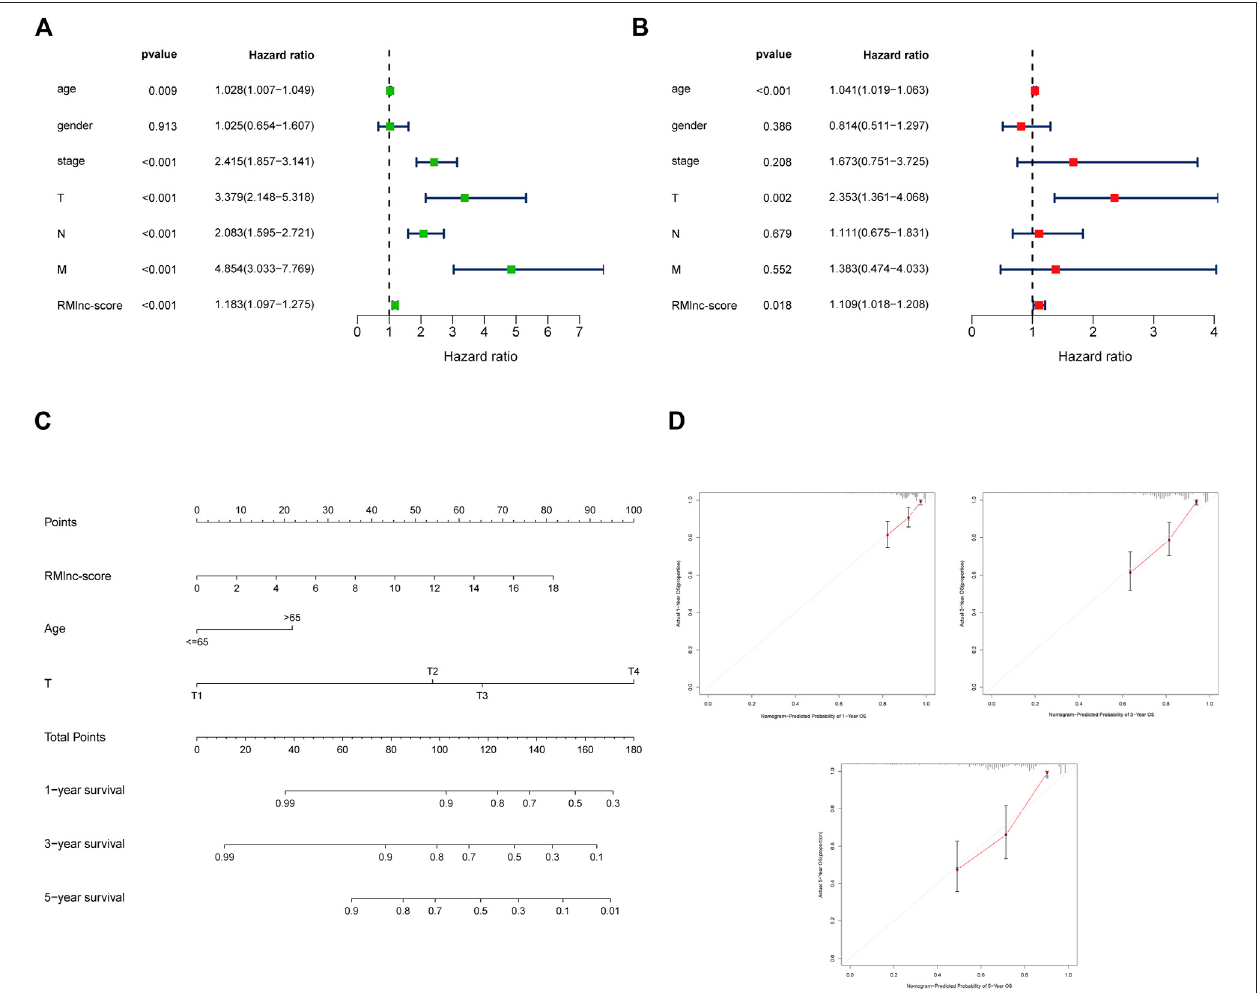
FIGURE 9 | Establishment of nomogram for predicting OS in colon cancer patients. (A) Univariate Cox regression analysis of clinical characteristics and RMlnc- score in CC samples. (B) Multivariate Cox regression analysis of clinical characteristics and RMlnc-score in CC samples. (C) The nomogram with multiple independent predictors, including age, T-stage, and RMlnc-score, was employed to predict 1-, 3-, and 5-years OS in patients with colon cancer. (D) Calibration curves of the nomogram for predicting 1,3,5-years OS.